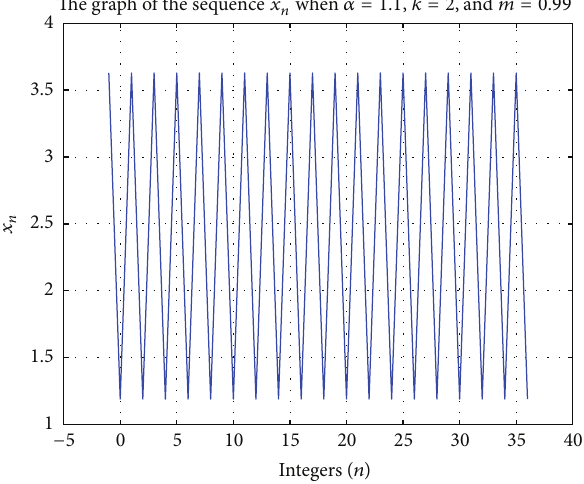
Figure 6: Existence of two-periodic positive solution, 𝜀 0 = 2.5281 , = 𝑥 = 3.6201 , and 𝑥 𝑥 −1